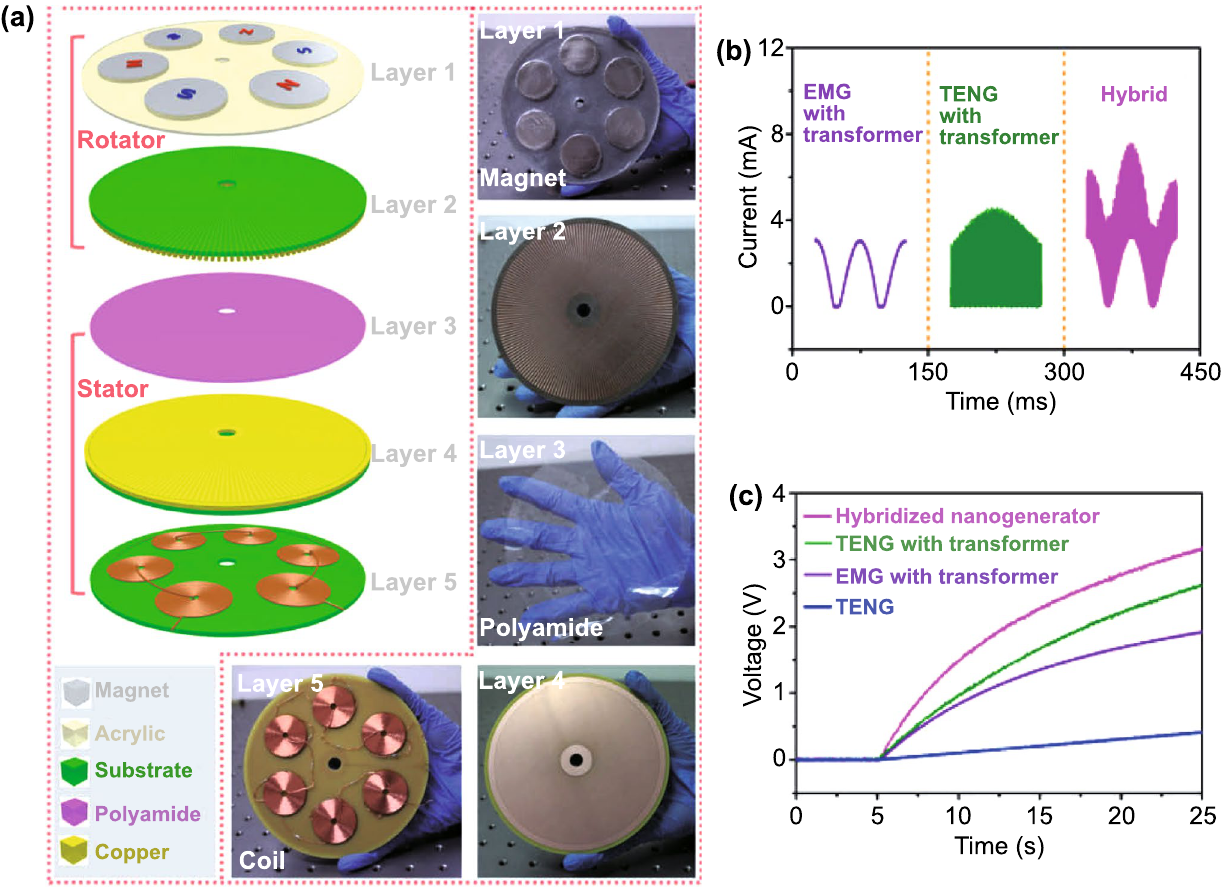
Fig. 9 a Schematic diagram and photographs of the rotating-disk-based hybridized EMG-TENG nanogenerator developed by Zhong et al. b Comparison of the SC current output for the EMG with transformer, TENG with transformer and the hybridized device. c Measured voltages across a 6600 μF capacitor charged by the TENG, TENG/EMG with transformer and the hybridized nanogenerator (EMG and TENG with trans- former in parallel). Reproduced with permission from Ref. [64]. Copyright 2014, Elsevier Ltd. All rights reserved. (Color figure